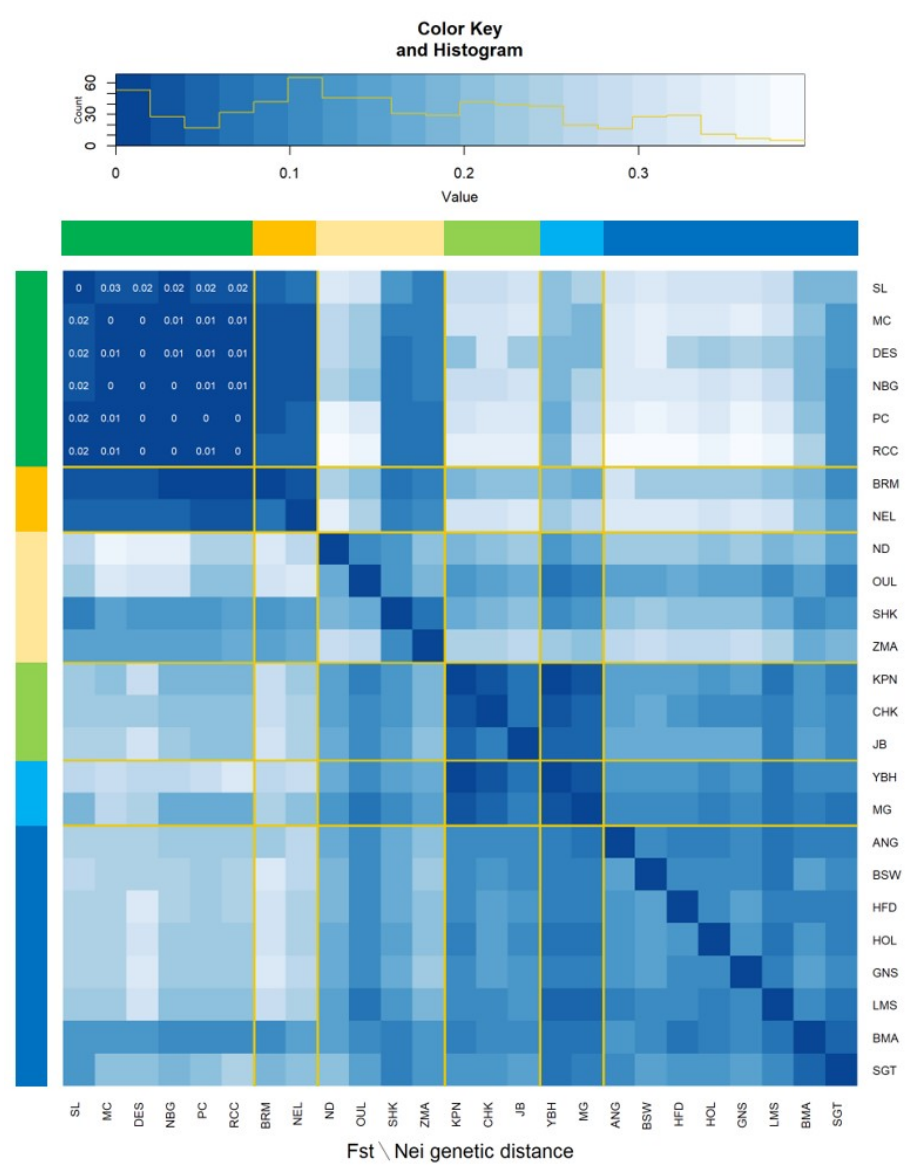
Figure 3. Heat map shows pairwise F ST (below diagonal) and Nei genetic distance (above diagonal) values for six Bangladeshi cattle populations (green), Indian zebu cattle (orange), African cattle populations (accent gold), Korean cattle (light green), Chinese cattle populations (light blue), and European cattle breeds (blue). The map was constructed utilizing 45,861 SNPs. Cattle breeds/populations abbreviations as in Figure 2. Pairwise F ST and Nei genetic distance values among six Bangladeshi populations are shown in the heat map.